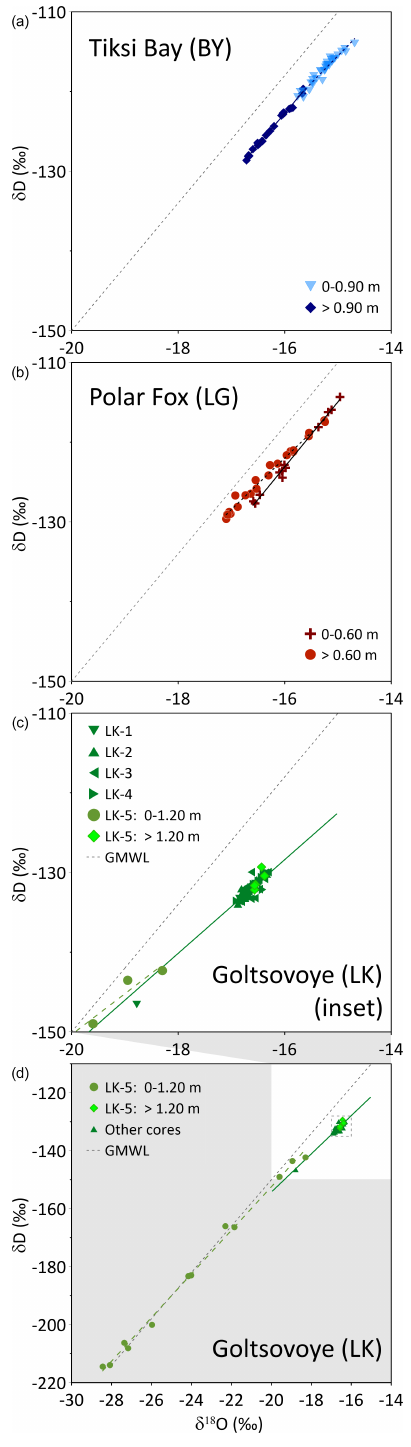
Figure 8. Isotope composition and linear regressions for Tiksi Bay (BY, a ), Polar Fox Lagoon (LG, b ) and Goltsovoye Lake (LK, c, d ) ice cores. For comparison, the global meteoric water line (GMWL, δ D = 8 × δ 18 O + 10; Craig, 1961, grey dotted line) is shown. The limits of the axes of the inset graph (d) differ from those